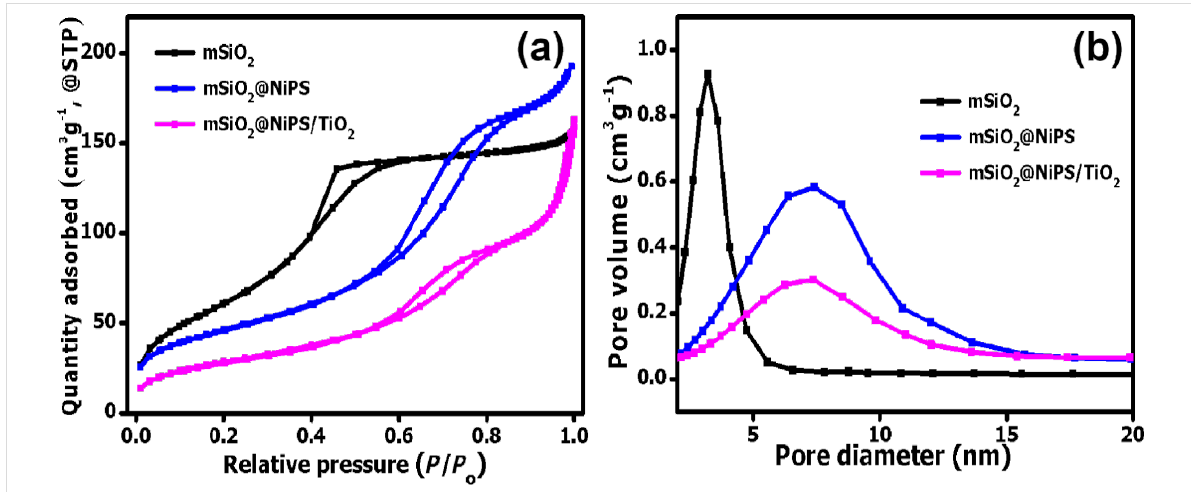
Figure 2: (a) N 2 adsorption–desorption isotherms and (b) pore size distribution of mSiO 2 , mSiO 2 @NiPS and mSiO 2 @NiPS/TiO 2 .